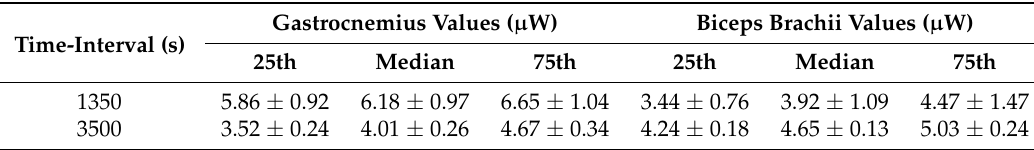
Table 3. Mean power values (n = 5). Working at desk activity.